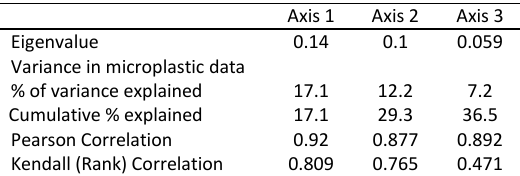
Table 4. CCA axis summary statistics